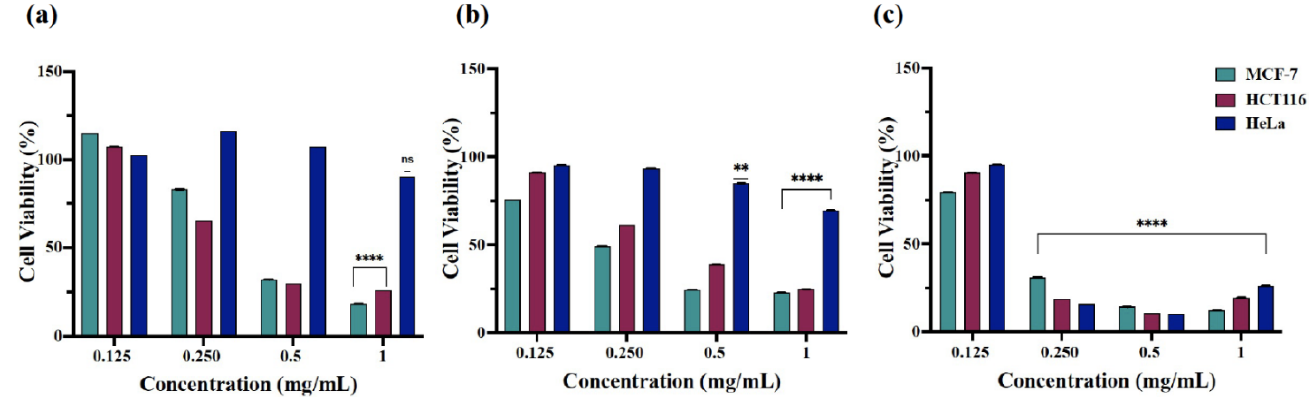
Figure 8. Cell viability (%) of MCF- 7, HCT116 and HeLa cells treated with β -Nb 2 ZnO 6 nanoparticles ( B ). The graph shows the cytotoxic effect of β -Nb 2 ZnO 6 ( B ) nanoparticles as highly significant (****) when compared with untreated (control) cells, ( a ) treatment for 24 h, ( b ) 48 h and ( c ) 72 h. P value is set at <0.05 (* if P ≤ 0.05, ** if P ≤ 0.01, *** if P ≤ 0.001, **** if P ≤ 0.0001).